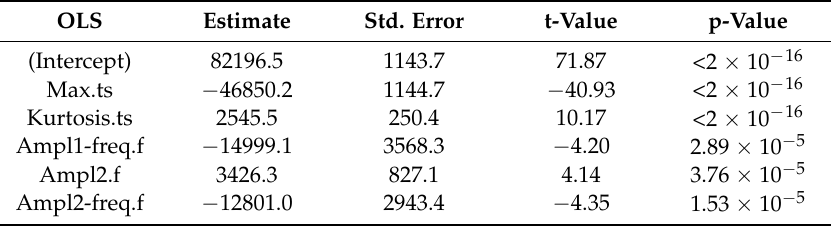
Table 6. Coefficient estimation of OLS of testing dataset k =